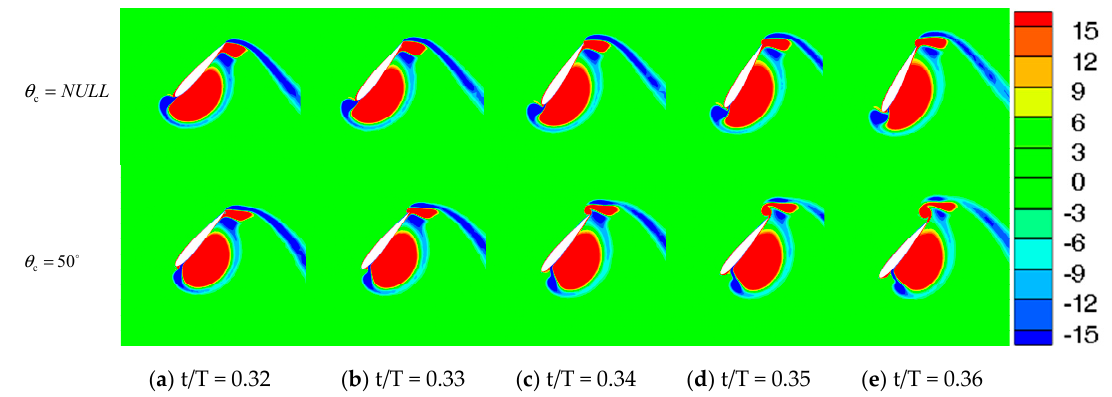
Figure 19. Instantaneous vorticity contours at t / T = 0.32–0.36 for di ff erent critical pitching amplitudes ( θ c = NULL and θ c = 50 ◦ , ( a ) t / T = 0.32, ( b ) t / T = 0.33, ( c ) t / T = 0.34, ( d ) t / T = 0.35, ( e ) t / T = 0.36).